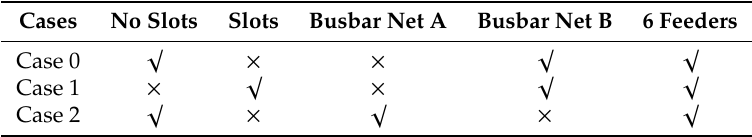
Table 2. Cases conducted in this paper.